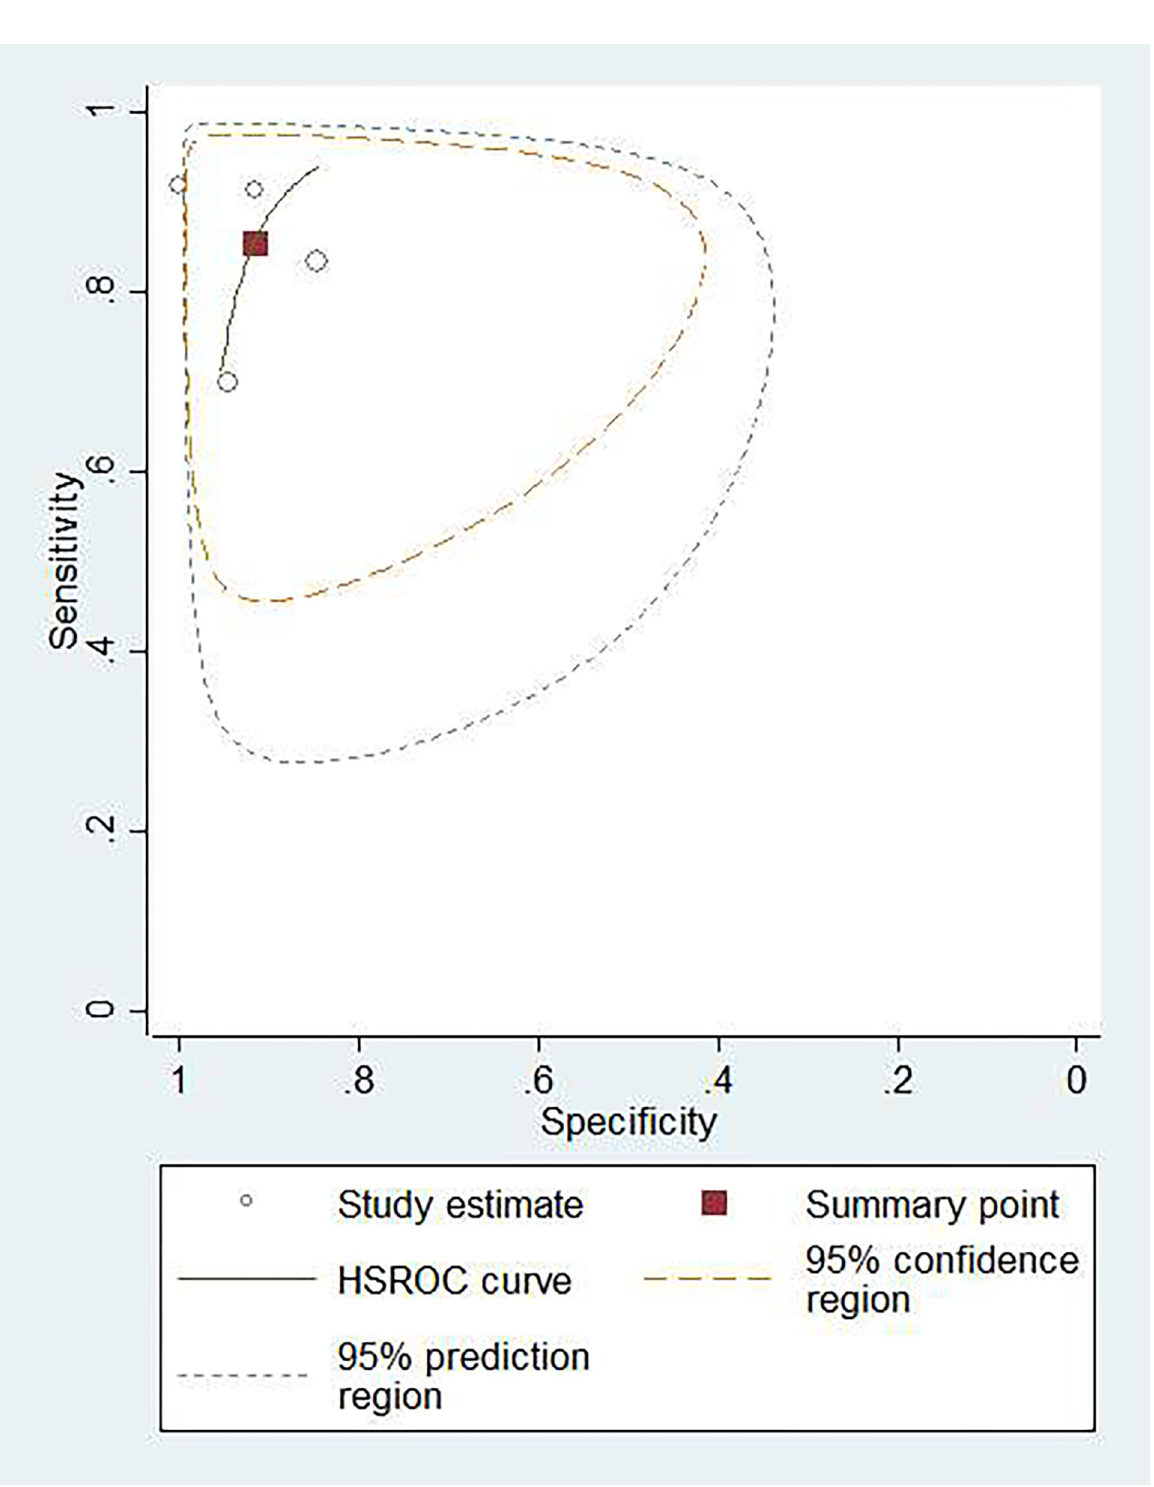
Fig 5. Hierarchical summary receiver operating characteristic (HSROC) plot to summarize diagnostic accuracy for unstimulated CSF IFN- γ in diagnosing tuberculous